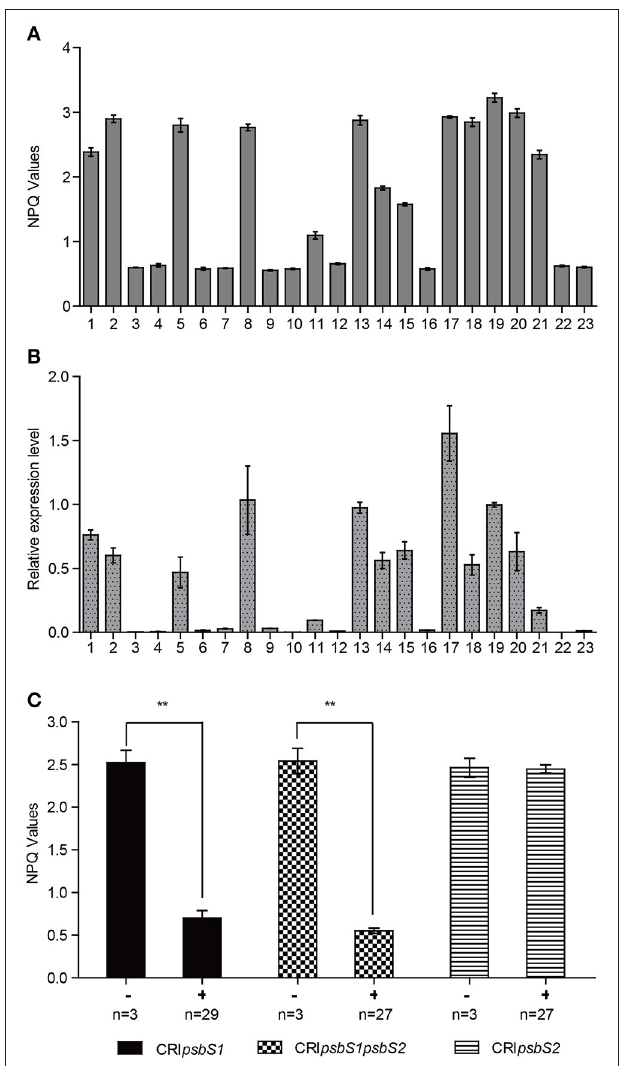
FIGURE 3 | The NPQ values in OsPsbS1 RNAi and CRISPR mutant plants. (A,B) The expression levels of OsPsbS1 (A) and corresponding NPQ values (B) in flag leaves of OsPsbS1 RNAi plants. (C) The NPQ values in CRISPR mutants targeting the single gene OsPsbS1 or OsPsbS2 and both of the two genes. The number of plants (n) were shown. **The differences in NPQ values between the wild type plants ( − ) and mutants ( + ) are significant at P < 0.01.